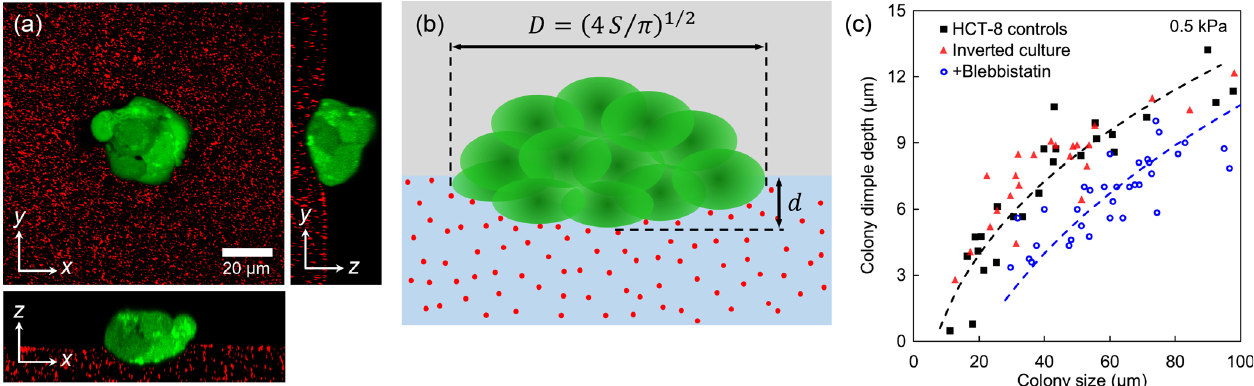
FIG. 1. HCT-8 colony indentation into soft PAA hydrogels. (a) Confocal images of colony indentation into the hydrogel. Cells live- stained with fluorescein diacetate (FDA) show green fluorescence, and the hydrogels are imbedded with red fluorescent beads. (b) Schematic of the configuration for the cell culture system containing an HCT-8 colony, hydrogel, and culture medium. Green: live cells stained with FDA. Light blue: hydrogel substrate embedded with red fluorescent beads. Gray: cell culture medium. Colony size is denoted as the equivalent diameter D ¼ ð 4 S= π Þ 1 = 2 , where S is the projected colony area. The colony is indented into the soft hydrogels, forming a dimple with depth d . (c) Colony size dependence of cell dimpling into the 0.5 kPa hydrogel. Colony size is denoted as the equivalent diameter calculated by the equation above. Black squares show the dimpling for the control HCT-8 colonies, while red triangles show the dimpling for the inverted cell culture. With blebbistatin, represented by blue circles, the dimples remain but the dimple depths are reduced for all of the colony sizes. Each datum point represents the dimple depth from one colony. Each group contains the combined data from three parallel experiments. The dashed lines are best-fit trend lines of the data